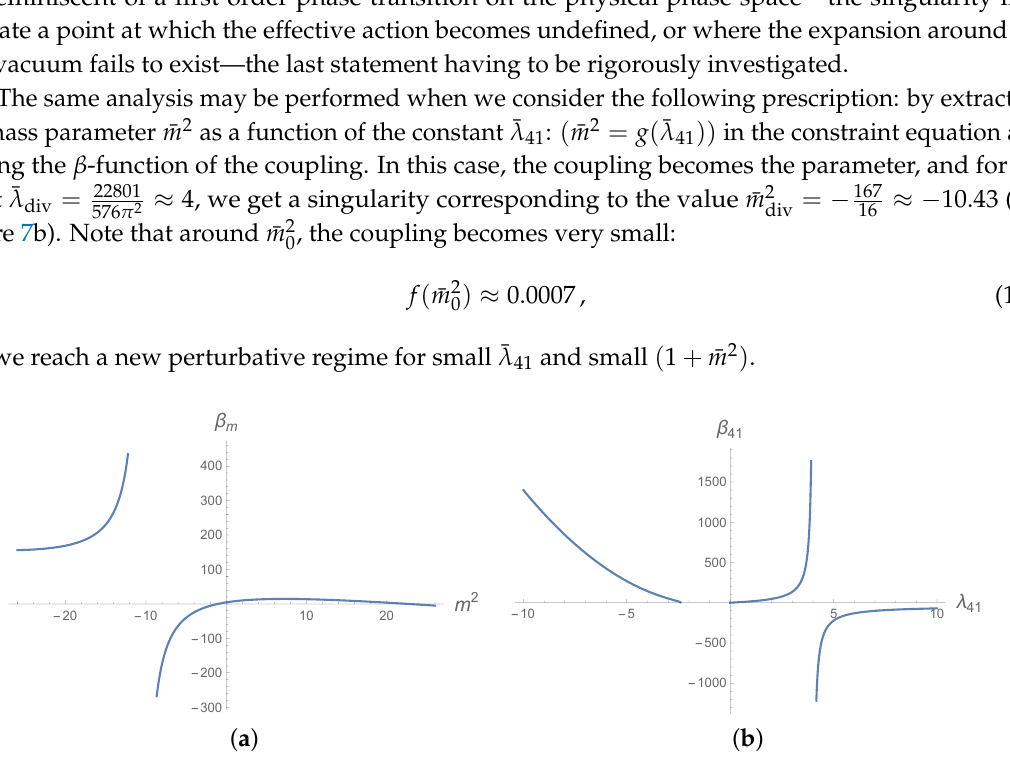
Figure 7. Plot of β m as a function of ¯ m 2 using the constraint equation. We get the singularity at the = − 167 point ¯ m 2 , corresponding to the coupling value ¯ λ div = 22801 16 div ¯ λ 2 = ¯ m 2 ( ¯ λ ) of the physical phase space. The singularity occurs at the 41 div in the parametrization ¯ m point ¯ λ div = 22801 ( b 576 π 2